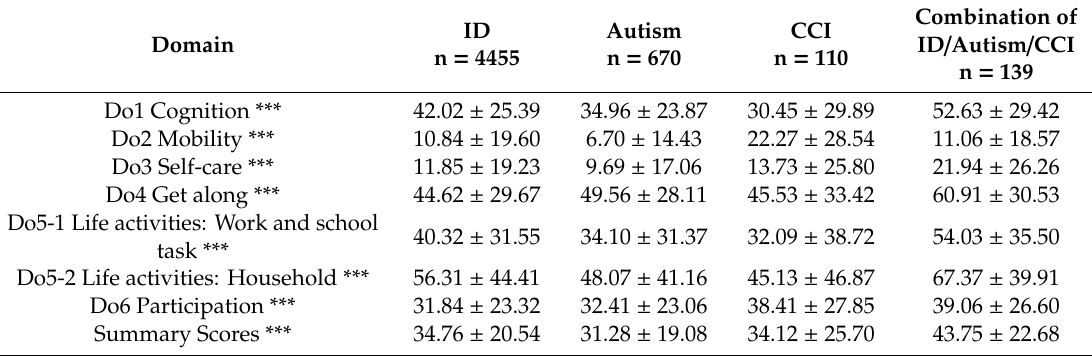
Table 3. The functioning scores means (Mean ± SD) of World Health Organization Disability Assessment Schedule (WHODAS) 2.0 between the four subgroups (n =